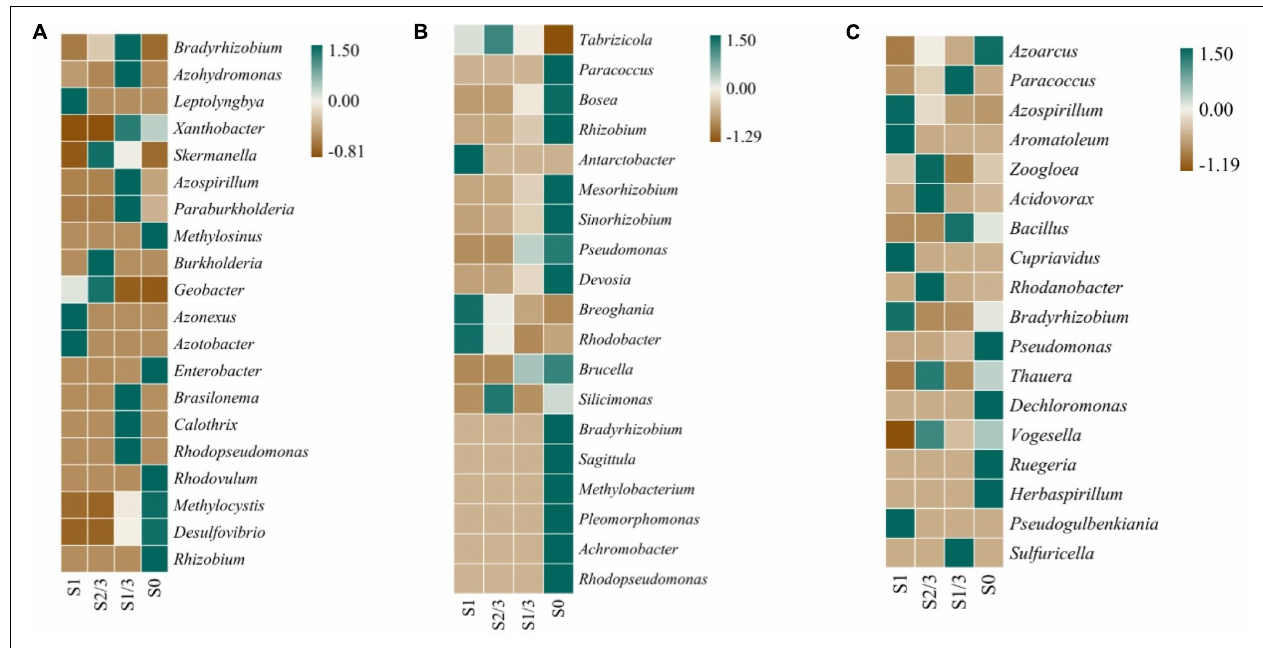
FIGURE 8 | Expression of nitrogen-fixing genes nifH (A) , nirK (B) and nirS (C) at bacteria